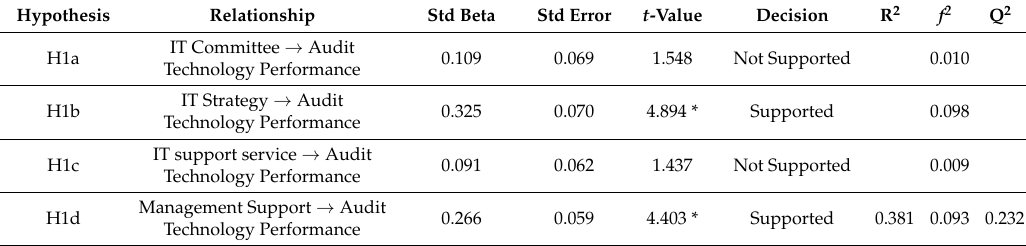
Table 5. Hypothesis